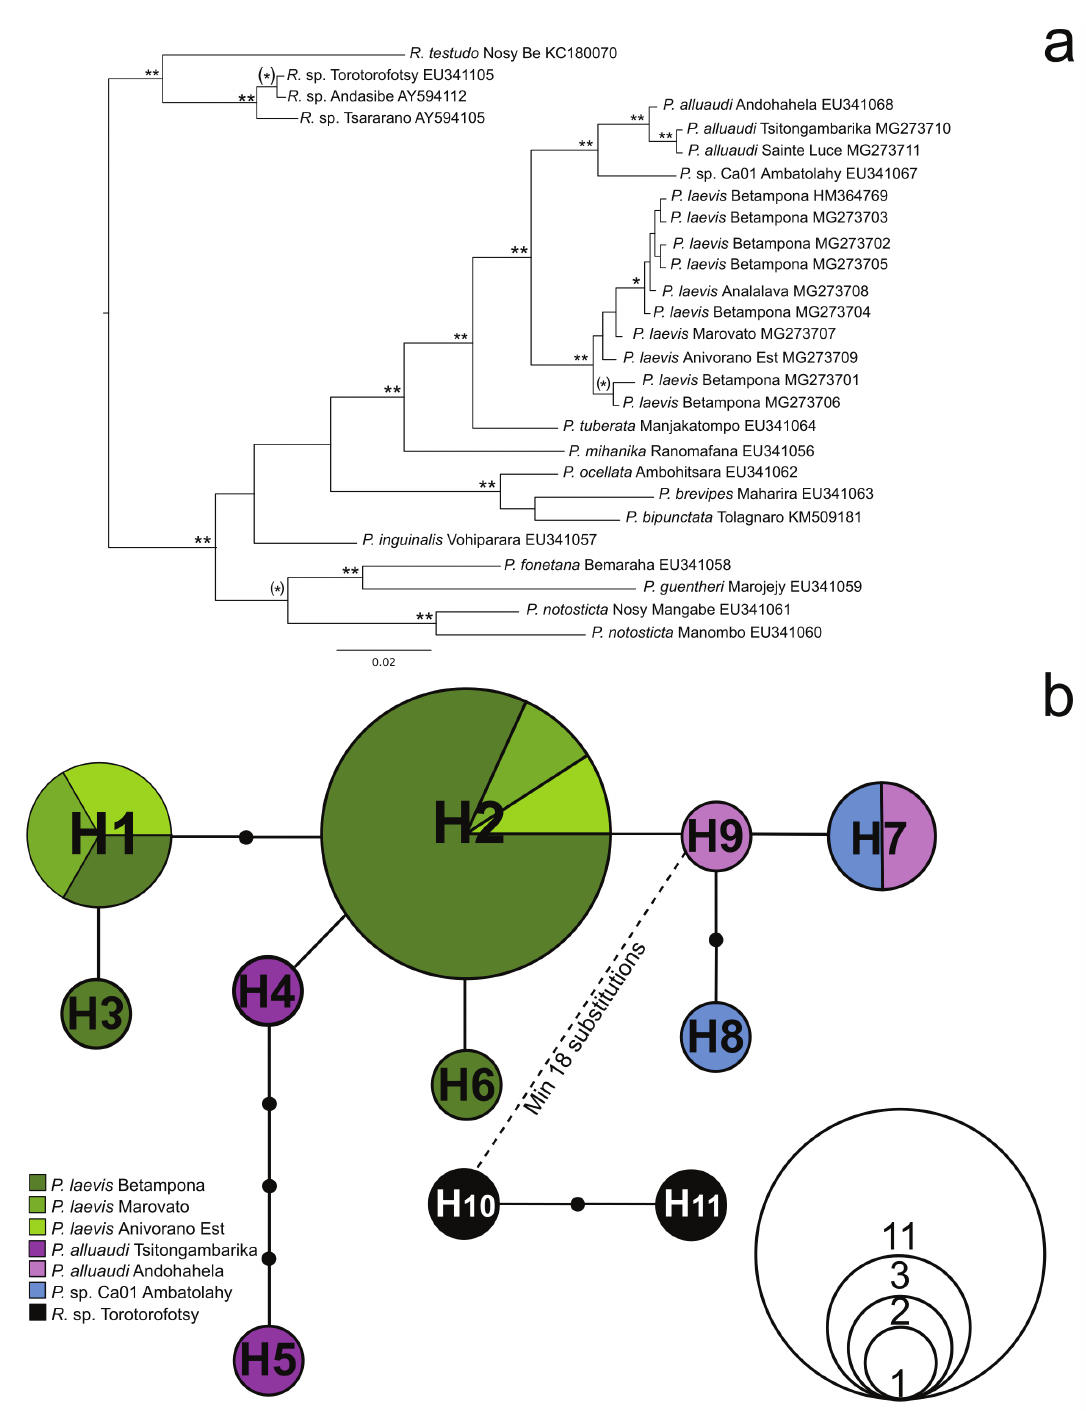
Figure 5. a ) Bayesian inference tree based on 529 bp of the mitochondrial 16S. Asterisks denote Bayesian posterior probabilities val- ues: one asterisk enclosed in parentheses, ≥ 90%; one asterisk, ≥ 98%; two asterisks, ≥ 99–100%. b ) Haplotype network reconstruction for the phased alleles of the nuclear POMC gene fragment in P. laevis from Betampona, Marovato and Anivorano Est, P. alluaudi from Tsitongambarika and Andohahela, P. sp. Ca01 from Ambatolahy and Rhombophryne sp. from Torotorofotsy.